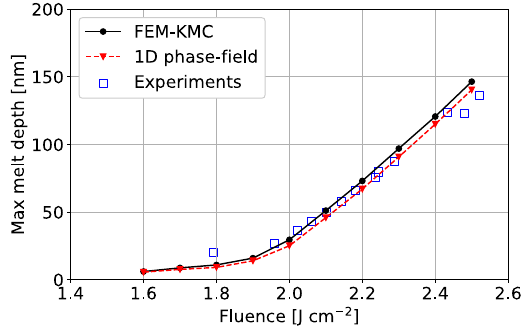
Fig. 5 Benchmark of FEM-KMC method against 1D phase- fi eld and experiments. The maximum melt depth as a function of laser fl uence is shown, simulated using the FEM-KMC and the 1D phase- fi eld approaches, in comparison with experimental data extracted from SIMS pro fi les measured on a Si sample after irradiation with a 308 nm and 160 ns laser